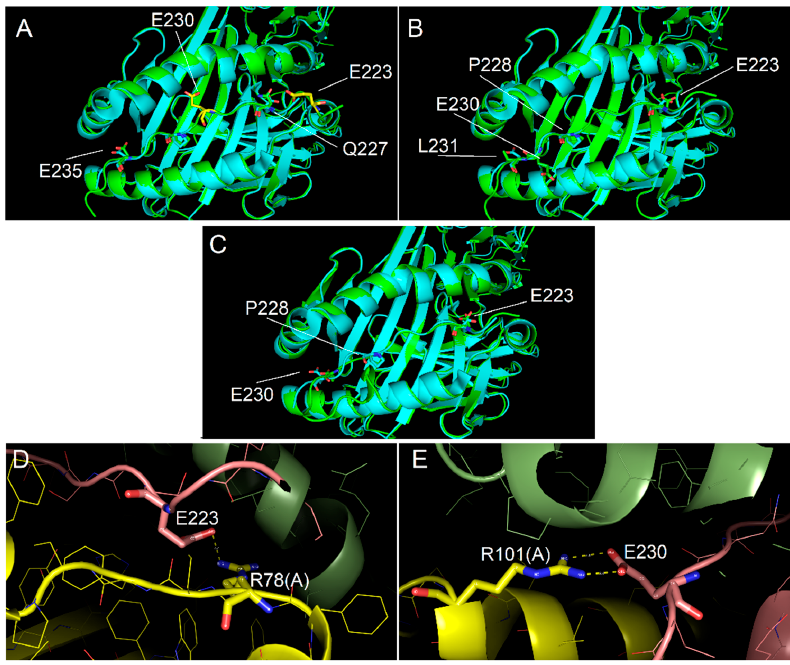
Figure 6. Interaction of p23 with DQ8 binding site. ( A – C ) Interaction models obtained with the alignment conditions named model 1, model 2 and model 3, respectively. As for Figure 5, cyan and green models overlapped showed the conformity of experimental (PDB code 2NNA) and modelled structures, respectively, of the DQ8 protein shown with backbone ribbon and of experimental peptide and modelled p23. Labels identify key residues of the modelled peptide, differently positioned in the binding groove as for the different alignment used. In model 3, all key residues of p13 are very close to the position of the corresponding residues of the template peptide in the anchor sites. ( D ) Detail of the salt bridge interactions between Arg78 of the DQ8 alpha chain and E223 of p23 observed for model 3. ( E ) Detail of the salt bridge interactions between Arg101 of the DQ8 alpha chain and E230 of p23 observed for model